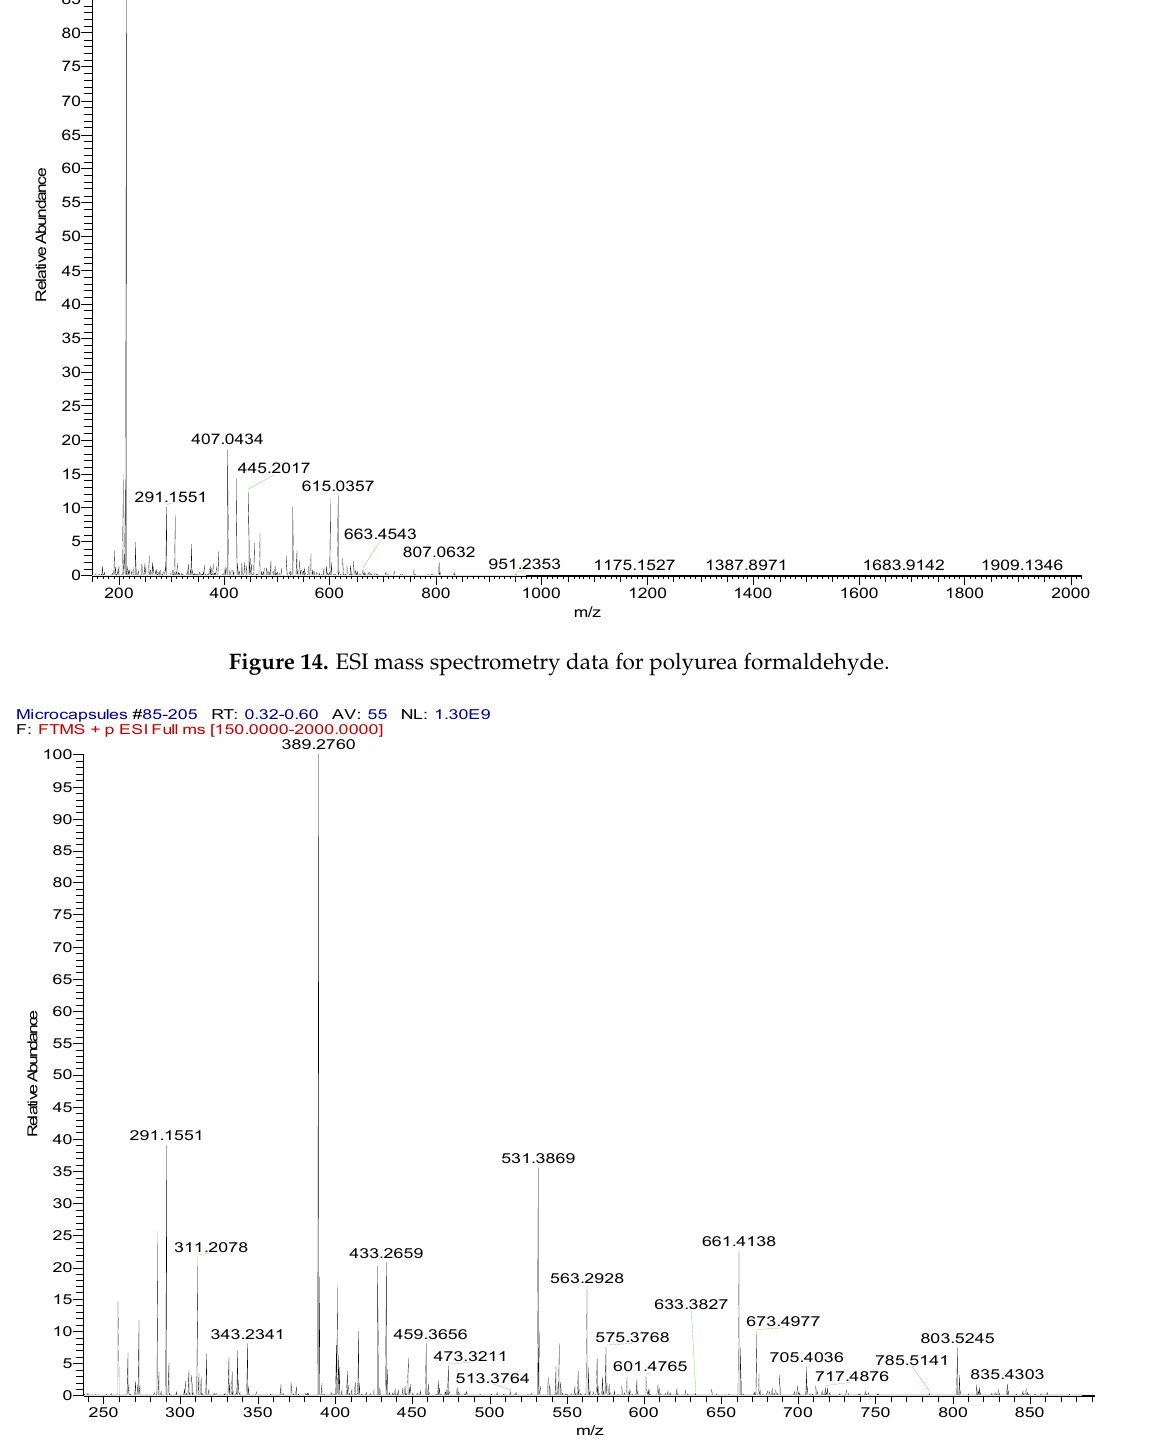
Figure 15. ESI mass spectrometry data for a microcapsule with a water-to-oil ratio of 5.5:1 aged for 4 months.